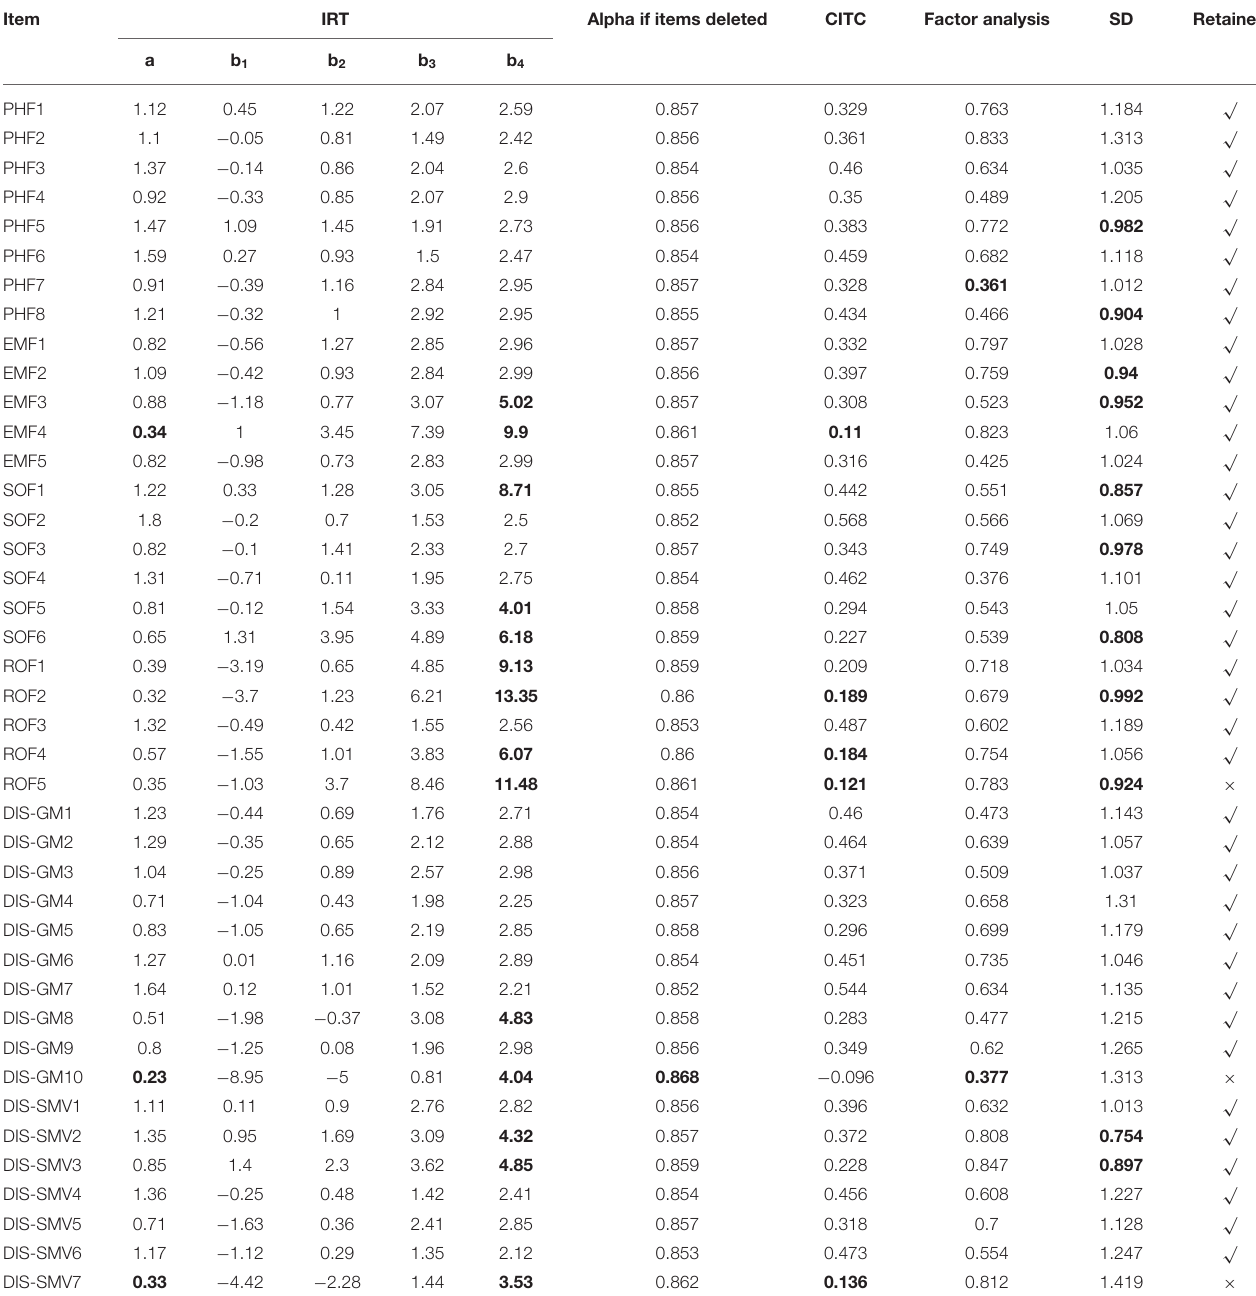
TABLE 2 | Screening results of the second item-selection phase using CTT and IRT.